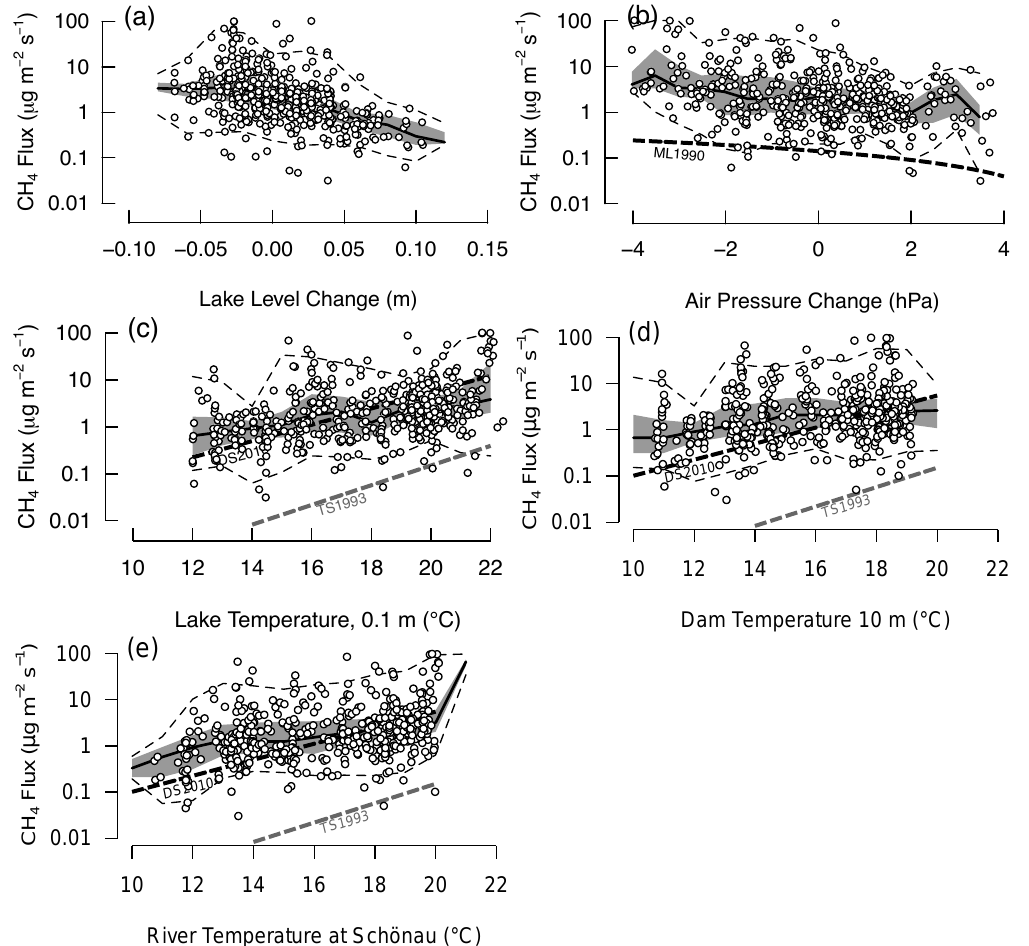
Fig. 9. Dependence of lake CH 4 effluxes from (a) lake level changes, (b) air pressure changes, (c) near-surface lake temperature, (d) 10-m water temperatures, and (e) upstream near-surface water temperatures. Individual 30-min flux averages (open circles) are ploted on top of bin-averaged median (bold line), interquartile range (gray band), and 95% confidence interval (broken lines). Bin sizes are: 0.02m for lake level changes, 0.5hPa for air pressure changes, and 1.0K for temperatures. As a reference for published pressure response the Mattson and Lichens (1990) curve is shown in panel (b) , and the temperature responses reported by Takita and Sakamoto (1993) and DelSontro et al. (2010) are shown in panels (c) – (e) with thick broken lines.